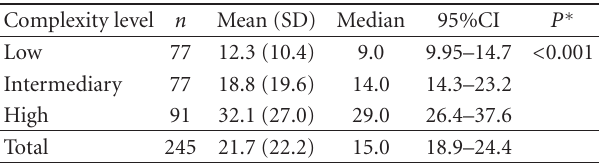
Table 3: Time of treatment by complexity levels among patients who completed